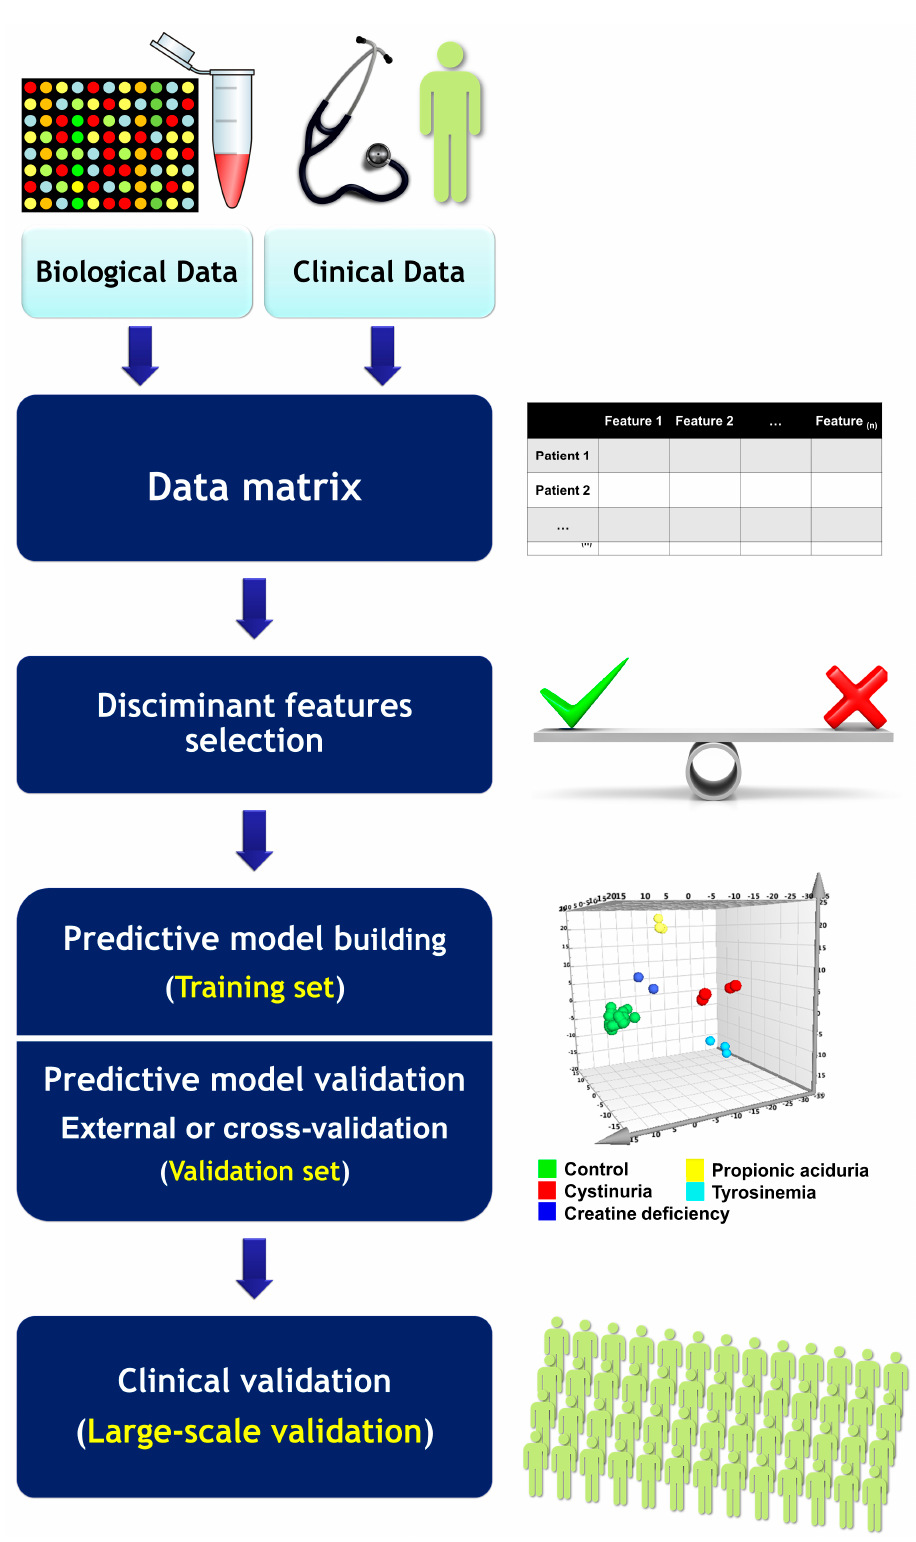
Figure 5. A stepwise approach to using machine learning methods for the prediction of clinical phenotypes. A training dataset is first collected. Then, a subset of features associated with the phenotype of interest is selected. Based on these features, a multi-variate model is built by the training data. A validation set acquired using the same omics profiling methods is collected and treated as new input to the established multi-variate model. The predictions provided by the model are used to assess the classification performance of the test input by comparing the model output and the actual clinical phenotypes of the patients in the validation set.